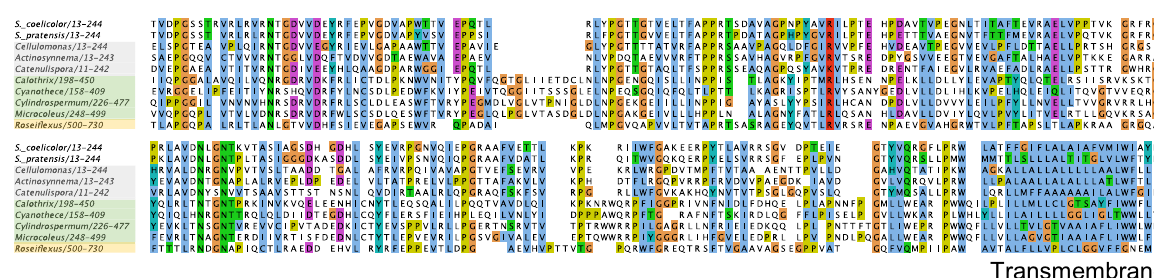
the conserved domains of proteins related to Sco4256 is shown. c A diverse selection of hits from a BLAST search initiated with Sco4242, the putative fi ber, were aligned. Sequences shown are from Streptomyces species (unshaded), other Actinomycete species (shaded gray). These proteins are found in type IId eCIS. All alignmentswereperformedwithMUSCLE 62 asimplementedinJalview 63 .Theclustal coloring scheme was